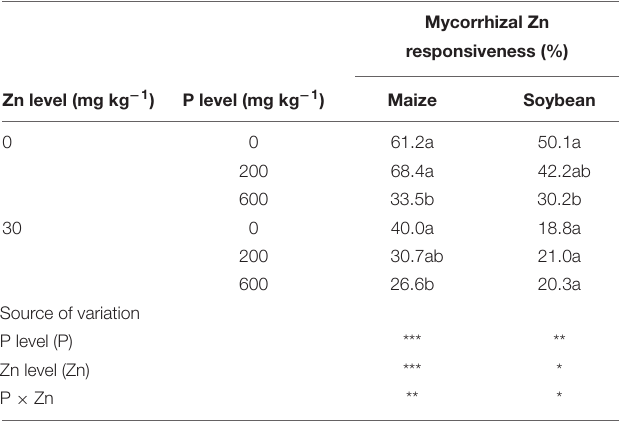
TABLE 3 | Mycorrhizal Zn responsiveness of maize and soybean affected by P and Zn applications, respectively.